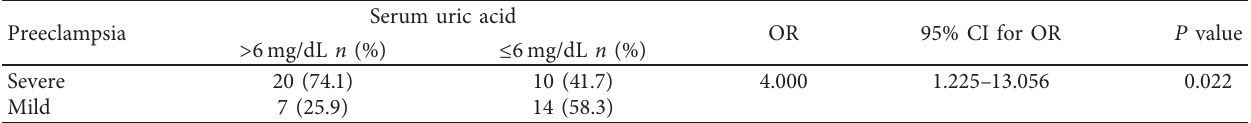
Table 5: Association between serum uric acid levels and severity of preeclampsia.